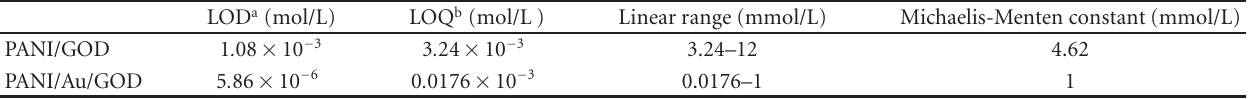
Table 1: Comparison of analytical performance of PANI and PANI-gold nanorod-enzyme film.